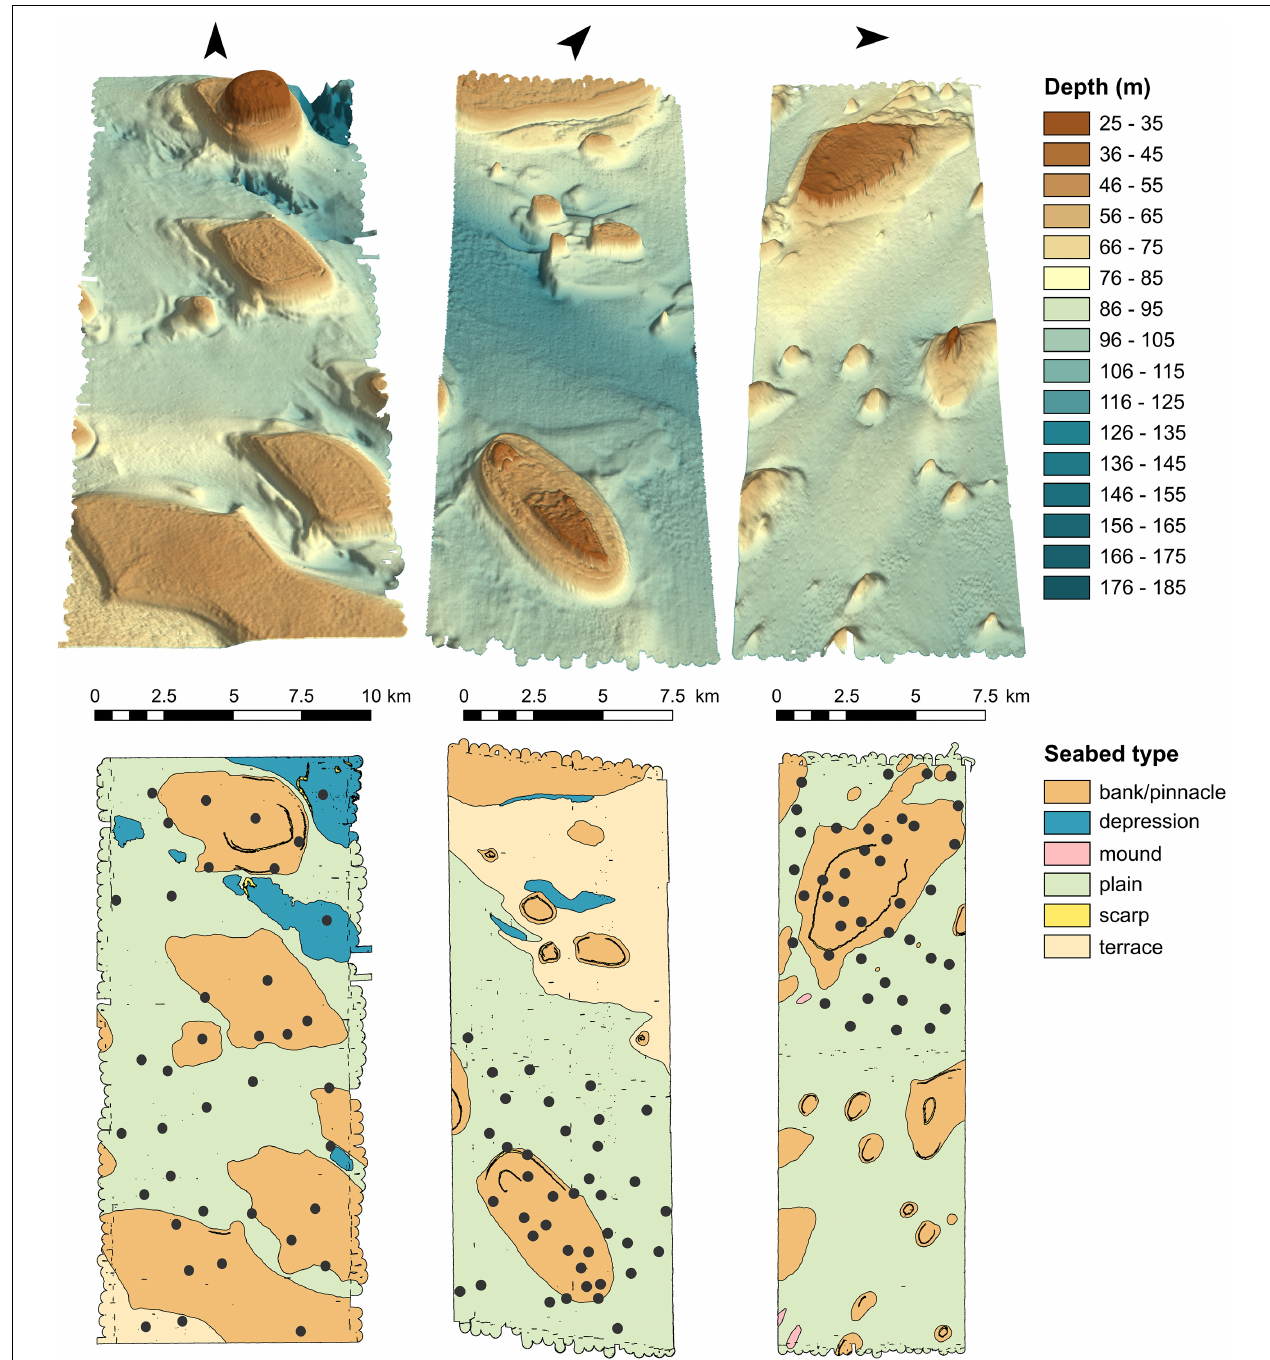
FIGURE 2 | Bathymetry and geomorphology of the three survey areas (1–3, from left to right). Three-dimensional images of the seafloor can be seen in the upper panel. The lower panel shows the distribution of geomorphic units, interpreted from multibeam mapping. Carbonate banks cover 40.8, 19.3, and 28.2% of each area, respectively. Black circles mark the positions of mid-water BRUVS sites. Arrows indicate the direction of compass north.